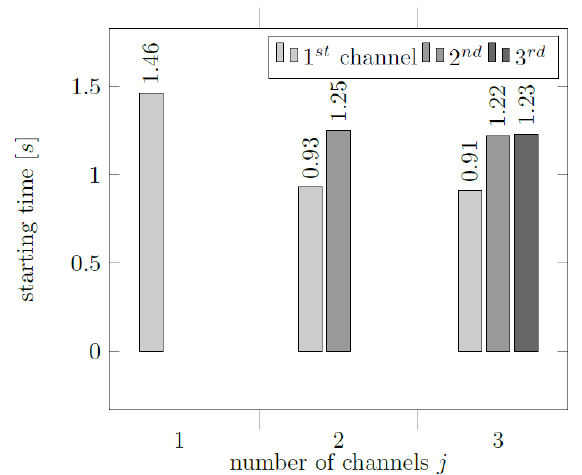
Figure 10. Starting times of the first cyclist in a channel for various queue configurations